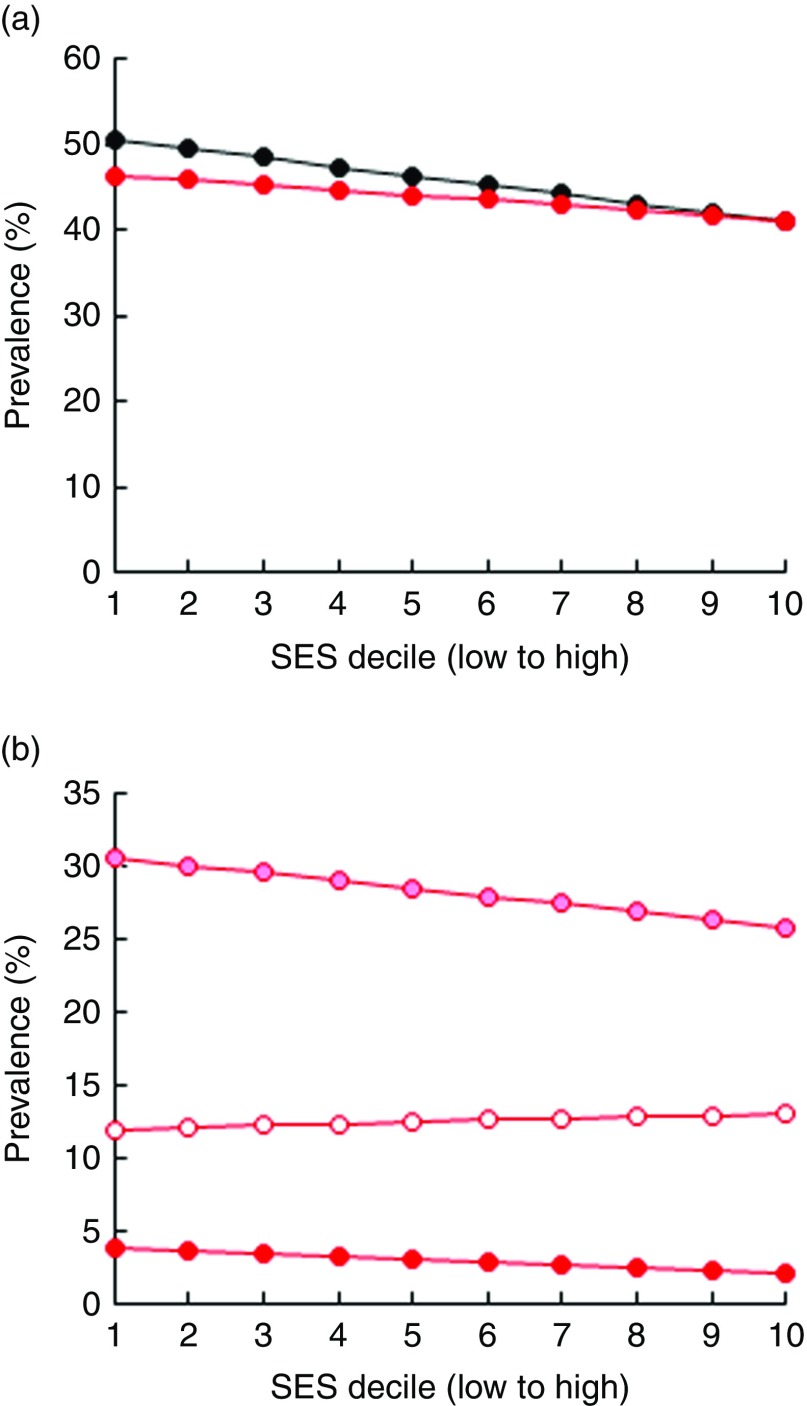
Prevalence of (a) iron-deficiency anaemia (IDA;
) and vitamin A deficiency (
) and (b) moderate IDA (
), mild IDA (
) and severe IDA (
) by socio-economic status (SES wealth index decile) among 6–23-month-old children from Faisalabad and Hyderabad districts, Pakistan (authors’ calculation based on Hb and serum retinol level data from the National Nutrition Survey 2011(

1

))